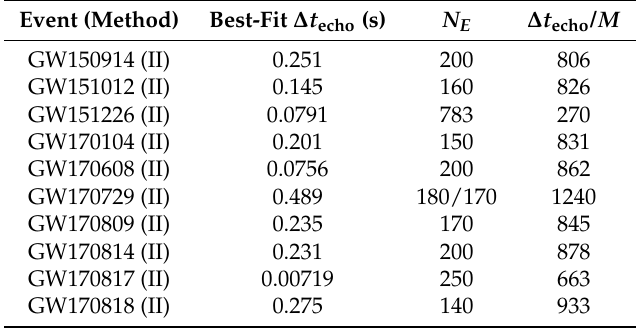
FIG. 6. Left: same as Fig. 5. Right: removal of spin and red-shift factors in (1).